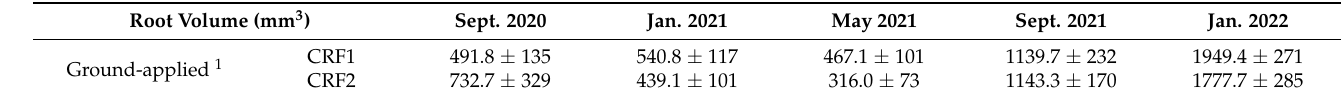
Table 6. Total root volume of ‘Ray Ruby’ grapefruit grafted on ‘Kuharske’ citrange planted in flatwood soils located in Fort Pierce, FL, USA, and treated with ground-applied fertilizer, foliar fertilizer and different planting densities from September 2020 to January